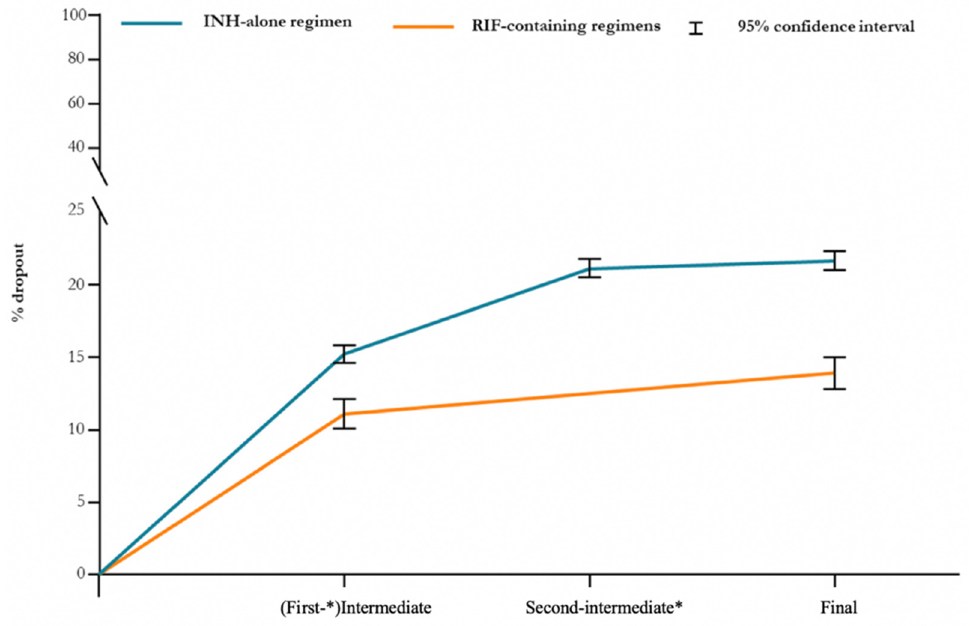
Figure 2. Dropout rate in individuals exposed to PT regimens ( n = 19,159). * Refers to an INH-alone regimen.